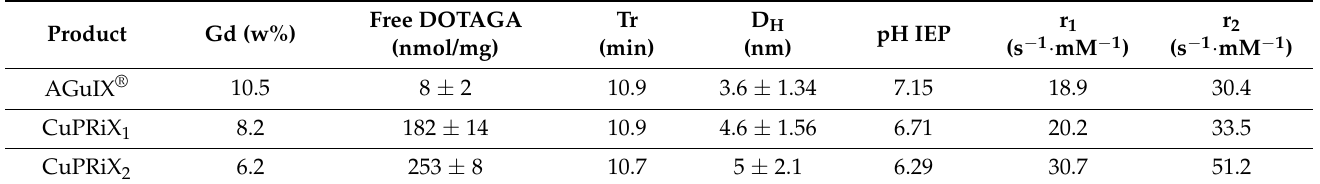
Table 1. Comparison of the chemical and physical characteristics of AGuIX ® , CuPRiX 1 and CuPRiX 2